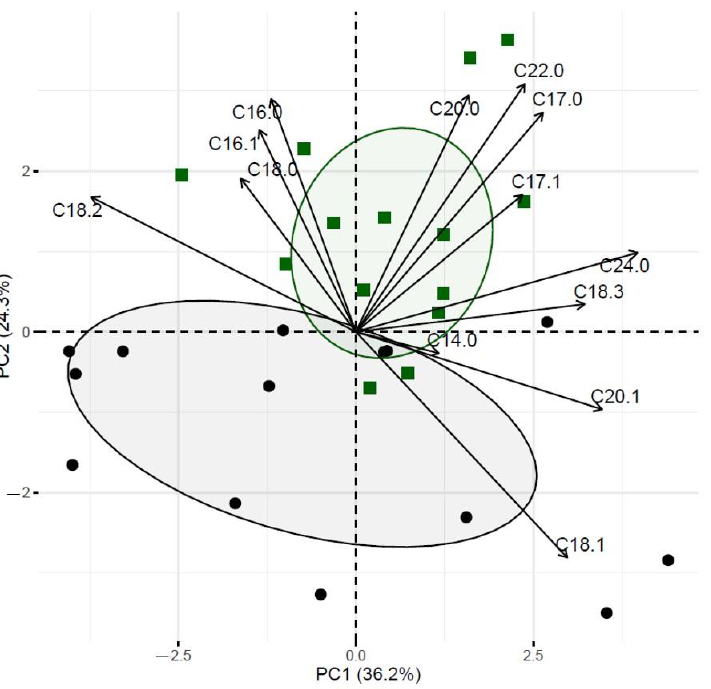
Figure 2. Differentiation of cv . Santulhana olives not subjected to frost ( ■ ) and subjected to